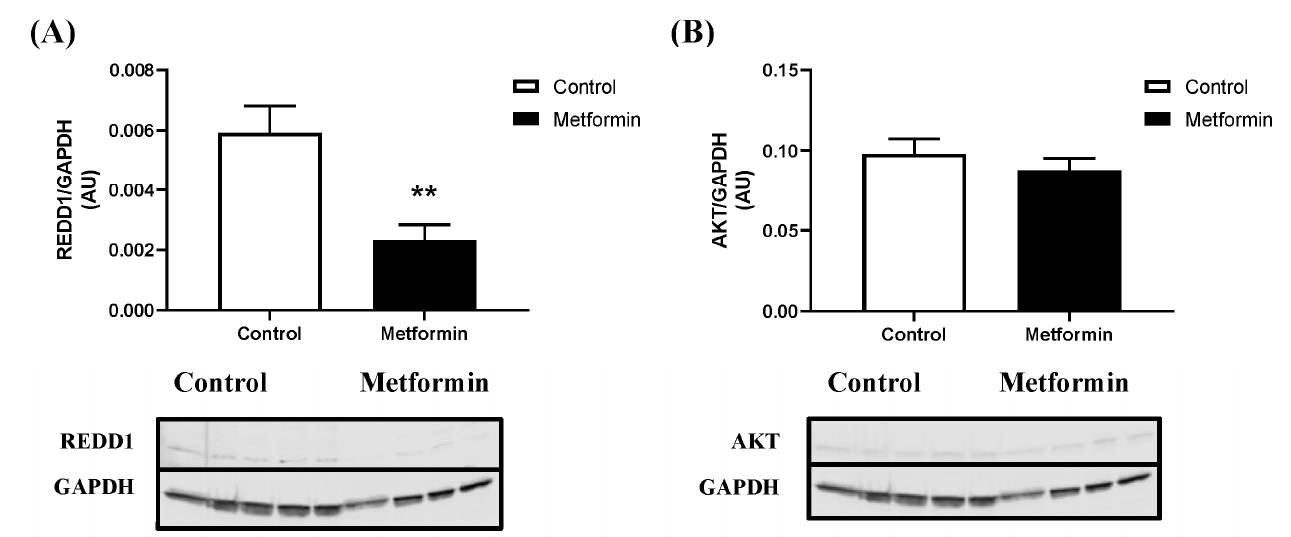
Figure 5. REDD1 and AKT expression in Lewis lung carcinoma cells treated with 10 mM metformin. ( A ) Regulated in development and DNA damage responses 1 (REDD1)/GAPDH expression (arbitrary units, AU) in LL/2 cells treated with or without 10 mM metformin. Data were analyzed using an unpaired t -test. ** p < 0.01 vs. control (n = 5). Data are mean ± SEM. ( B ) Protein kinase B (AKT)/GAPDH expression (arbitrary units, AU) in LL/2 cells treated with or without 10 mM metformin. Data were analyzed using an unpaired t -test ( p = 0.4135). Sample size: n = 5. Data are mean ± SEM.